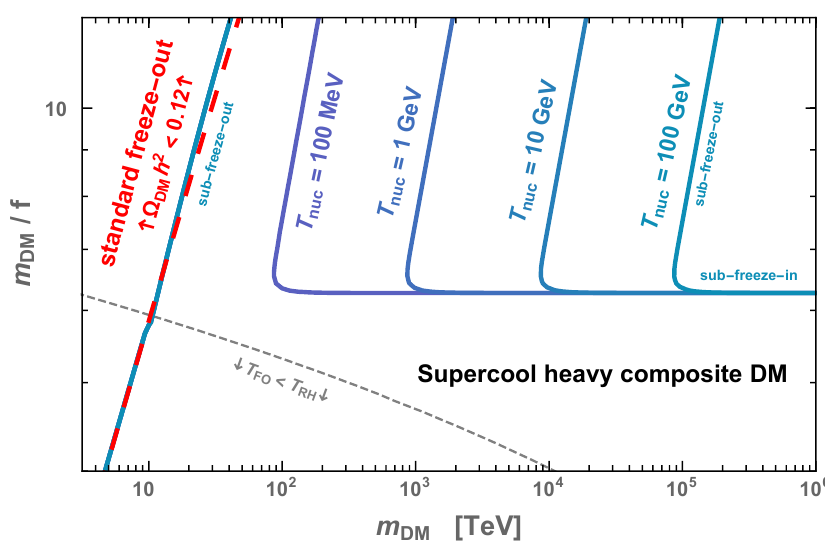
Figure 1 . The abundance of scalar composite DM is reproduced along the red dashed line in the case of standard freeze-out, and along the blue lines in presence of a supercooled phase-transition, for different values of the nucleation temperature T . See eq. (4.18) and eq. (4.19) for a description nuc of the sub-freeze-out and sub-freeze-in regimes. See figure 6 for analogous figures with experimental limits and sensitivities superimposed. This figure has been drawn for Z = 5 (defined in section 2.1) and BR = 10 − 6 (defined in eq. (4.16)). If the reheating temperature is smaller than the freeze-out one T . T , then the phase transition results in a slightly different DM abundance than the RH FO standard case even for vanishing supercooling (large T ), cf. eq. (4.18), so that the red and the nuc leftmost blue lines do not